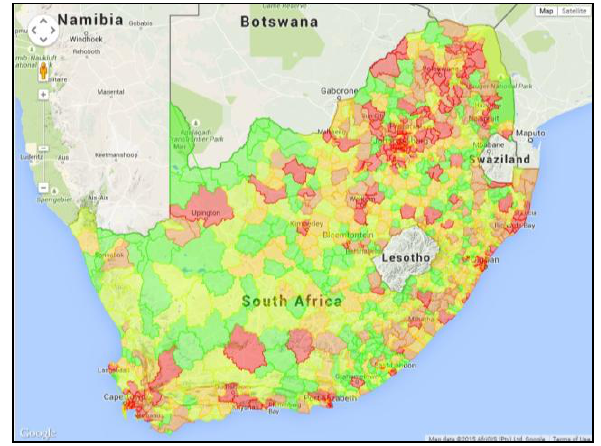
Figure 3: SAPS crime “hot spot” map of South Africa (© 2014 Crime Stats SA)